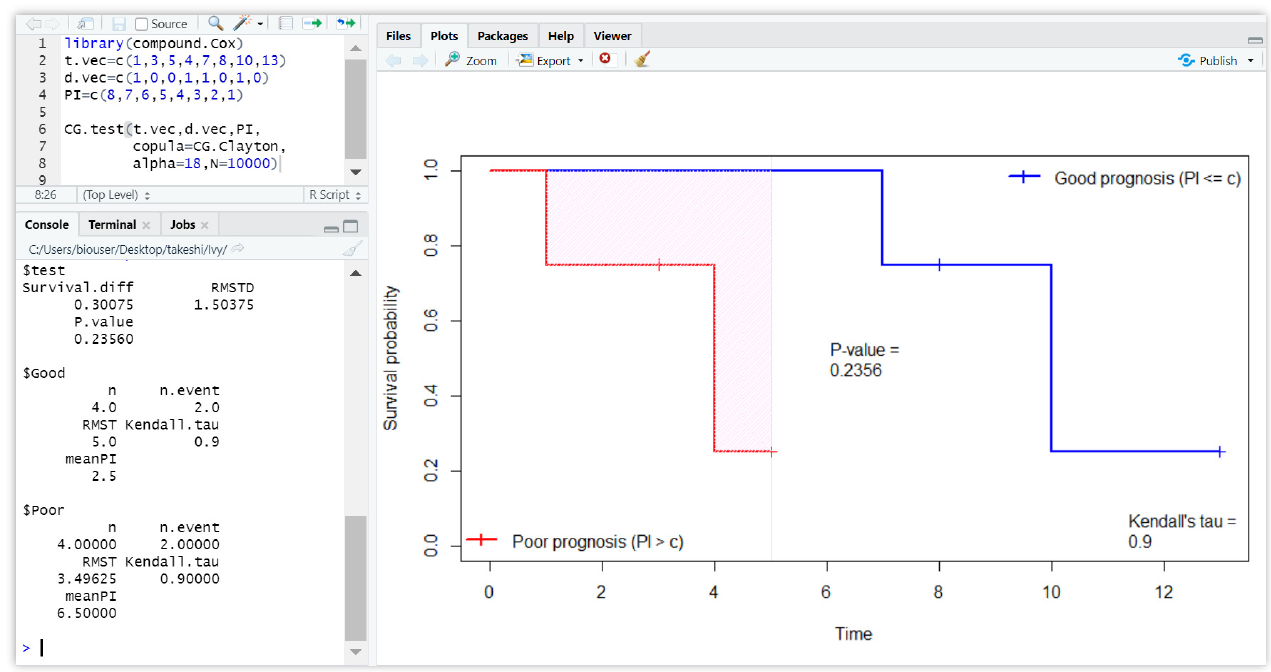
Figure 3. The R console showing the test results for the difference for the good and poor prognoses. The right panel gives the plots of the Clayton CG estimates computed by data t i = 1, 3, 5, 4, 7, 8, 10, 13; δ i = 1, 0, 0, 1, 0, 1, 0; PI i = 8, 7, 6, 5, 4, 3, 2, 1. The Clayton copula’s parameter is specified as α = 18. More detailed results, such as the difference ( D ) and the RMSTD ( τ D ), are given in the left panel.